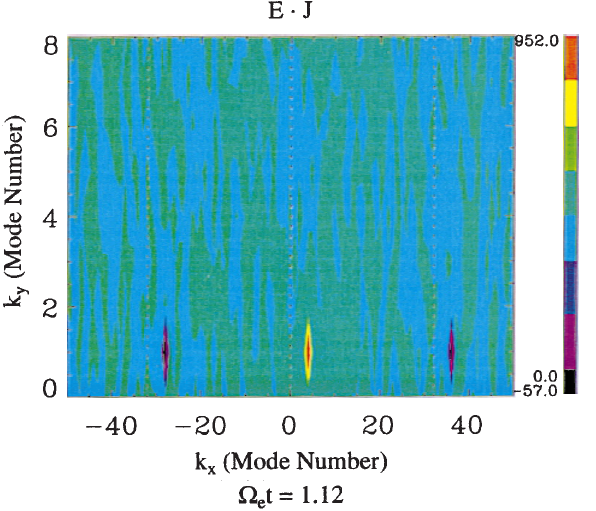
Fig. 5. E (cid:1) J in 2D wave number space at t (cid:136) 1 : 12 = (cid:88) e . The positive E (cid:1) J ( bright color ) represents the wave damping, while the negative values ( dark color ) correspond to the wave growth. The energy conversion from the pump wave ( k x (cid:136) 4, k y (cid:136) 1) to the excited waves (cid:133) k x (cid:136) 36 ; (cid:255) 28 ; k y (cid:136) 1 (cid:134) occurs under the matching condition in the wave number space